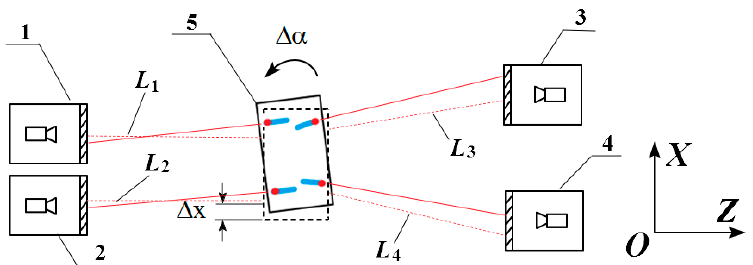
Figure 23. Test sketch map. 1. reference monitoring image acquisition module A; 2. reference monitoring image acquisition module B; 3. image acquisition module I; 4. image acquisition module II. ( (cid:1838) (cid:2869) = 40 m, (cid:1838) (cid:2870) = 46 m, (cid:1838) (cid:2871) = 35 m, (cid:1838) (cid:2872) = 38 m).